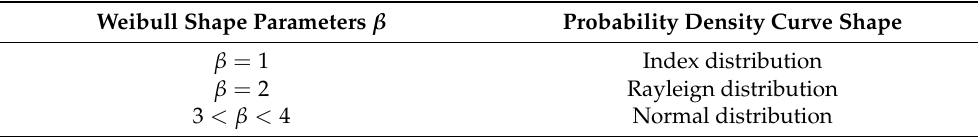
Table 10. Relationship between shape parameters and probability density